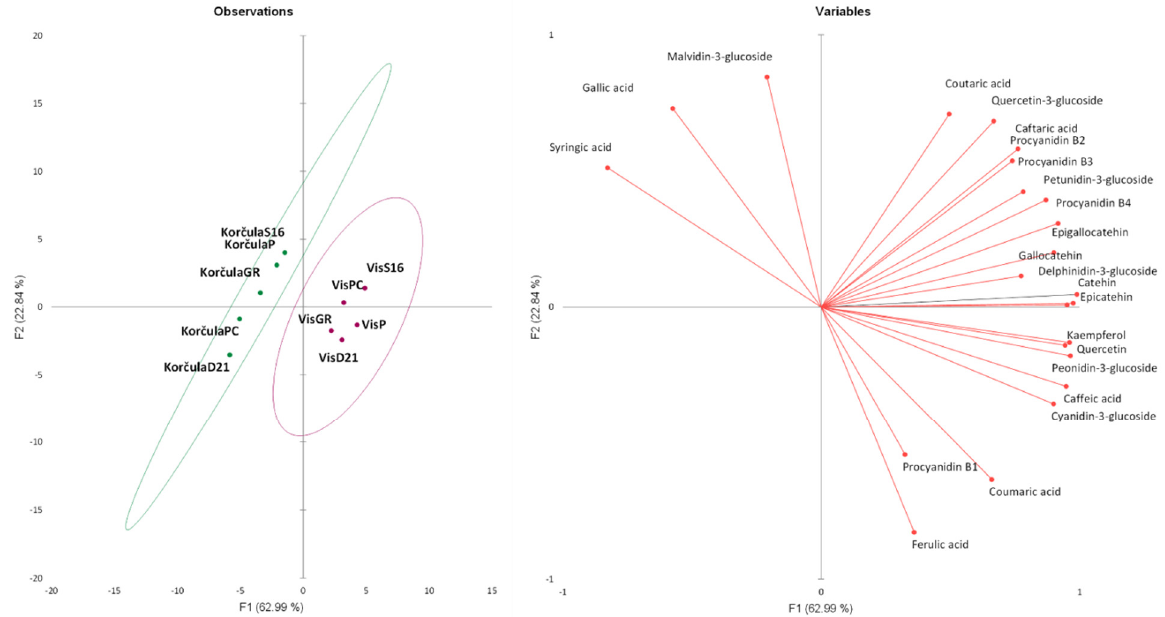
Figure 2. Principle component analysis (PCA): distribution of the cv. Plavac mali wine samples (observations) from two different locations (Islands Vis and Korˇcula) in two-dimensional coordinate system defined by the first two principal components (PC1 and PC2) according to the polyphenolic profiles (variables). Confidence ellipses are presenting 95% confidence intervals of two group of variables.